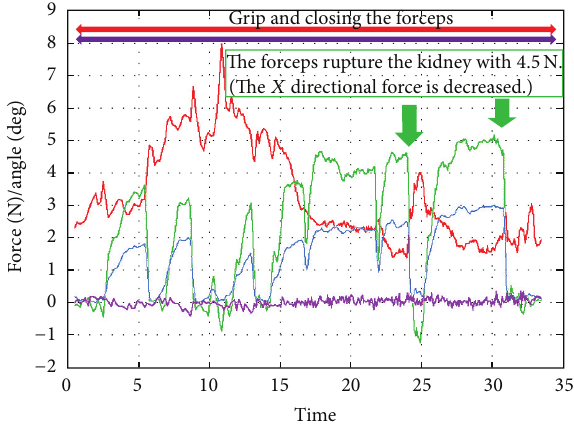
Figure 6: Experiment (A), rupture the kidney.